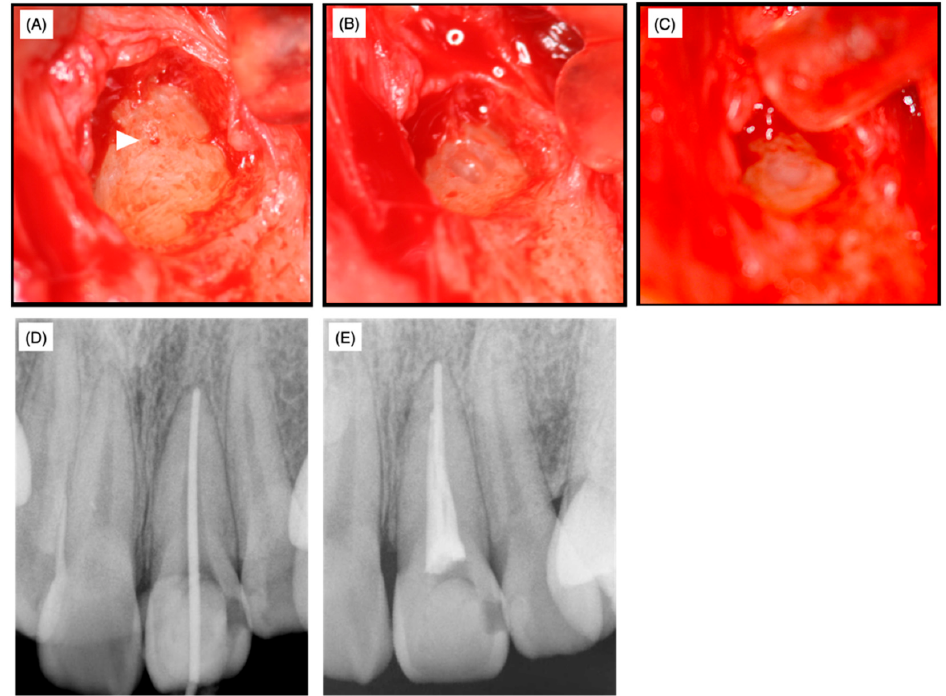
Figure 4. Operative photographs after granular tissue removal ( A ), after cavity preparation ( B ) and after sealing with composite resin ( C ). The arrowhead in ( A ) indicates the lateral foramen. X-ray films before ( D ) and after ( E ) root filling. The fitness of gutta-percha points in the apex was examined ( D ).